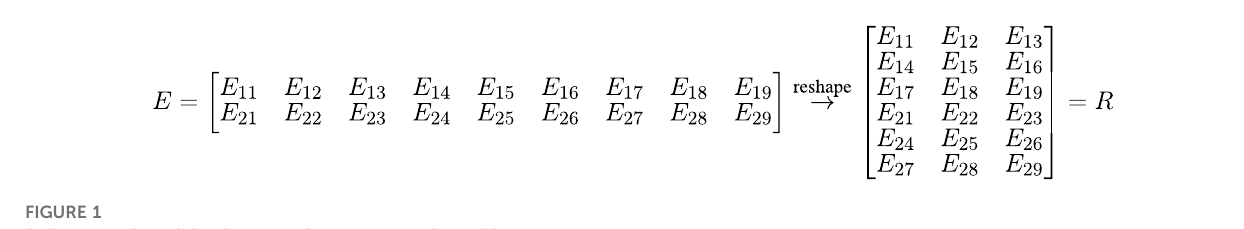
FIGURE 1 A demonstration of the data wrapping process performed by